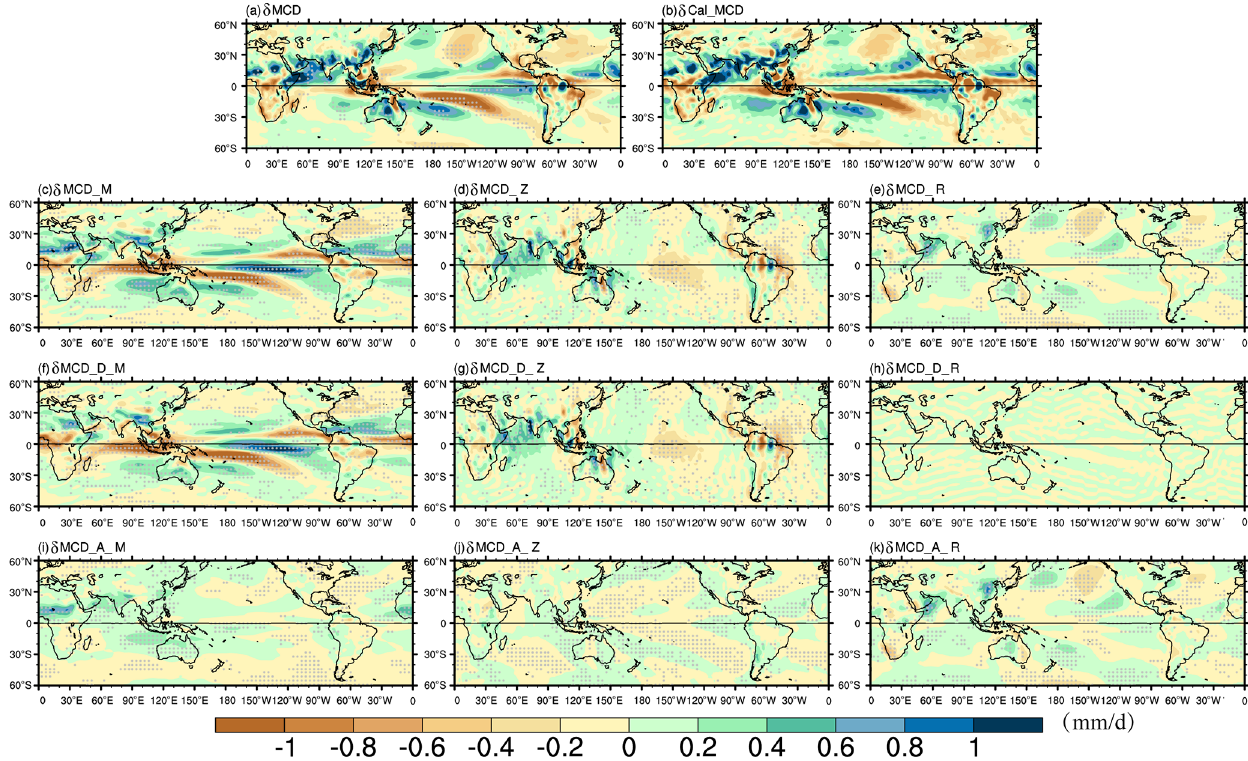
Figure 4. The annual mean changes in the moisture budget components of the mid-Pliocene minus the PI control of the PlioMIP2 multi- model mean, which reflect (a) the dynamic term and (b) the estimated change in the dynamic term (calculated as the sum of the right-hand side terms in Eq. 9 of the 3P-DGAC decomposition method). The contributions to the changes in the dynamic effect include the dynamic term induced by the anomalous (c) meridional, (c) zonal, and (d) horizontal circulations. The corresponding changes in panels (f–h) and (i–k) are the terms in the components shown in panels (c–e) that are related to the change in divergent flow and mean moisture advection, respectively. Stippling indicates regions where at least 10 of 13 simulations in the model group agree on the sign of the ensemble mean. (Units are mmd − 1